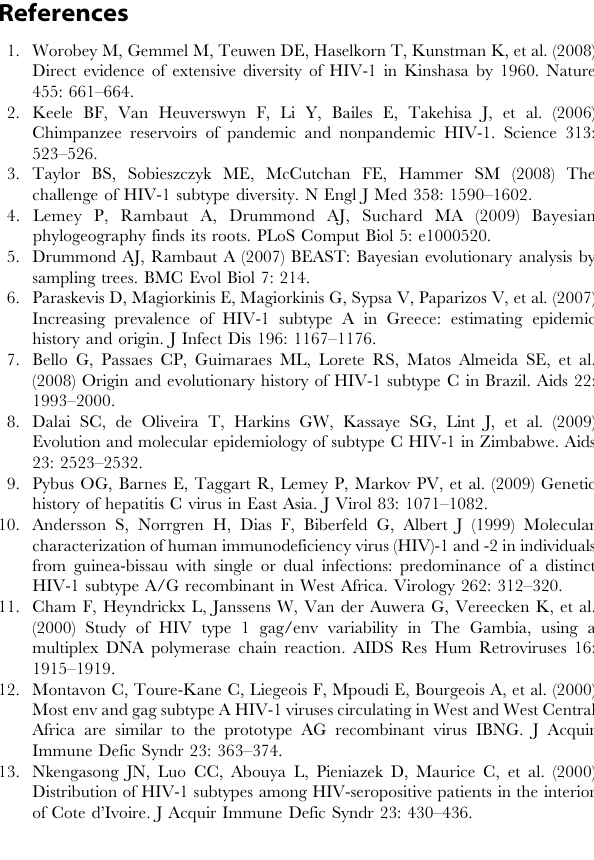
Table S1 Sampling year, date of seroconversion, sample place, and HIV-1 subtype or CRF of the 82 analyzed study subjects. (DOC) Table S2 Estimated substitution rates and dates for the CRF02_AG and subsubtype A3 datasets by different Bayesian demographic models. Table S3 Accession numbers of reference sequences represent- ing subsubtypes A1, A2, A3 and the CRF02_AG used for detailed subtyping of the subtype A-like sequences from Guinea-Bissau. Table S4 Accession numbers of reference sequences represent- ing the CRF02_AG used for Guinea-Bissau-specific cluster identification. Table S5 Accession numbers of reference sequences represent- ing subsubtype A3 used for Guinea-Bissau-specific cluster